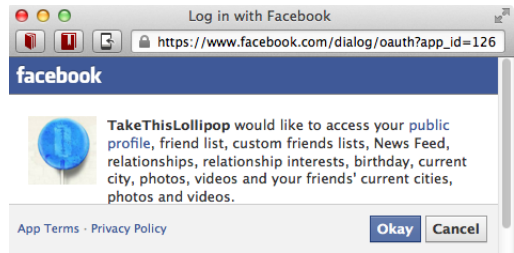
Figure 2. Data access requested by Take This